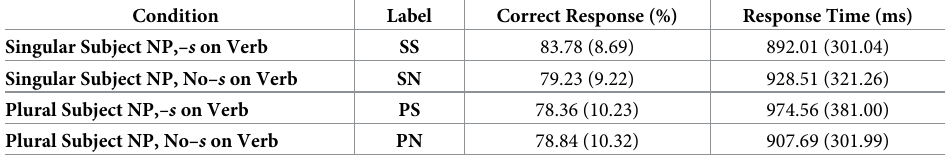
Table 4. Mean percent correct response (%), response times (ms), and their SDs (in parentheses) for each condi- tion in the behavioral task for the auditory ERP experiment.